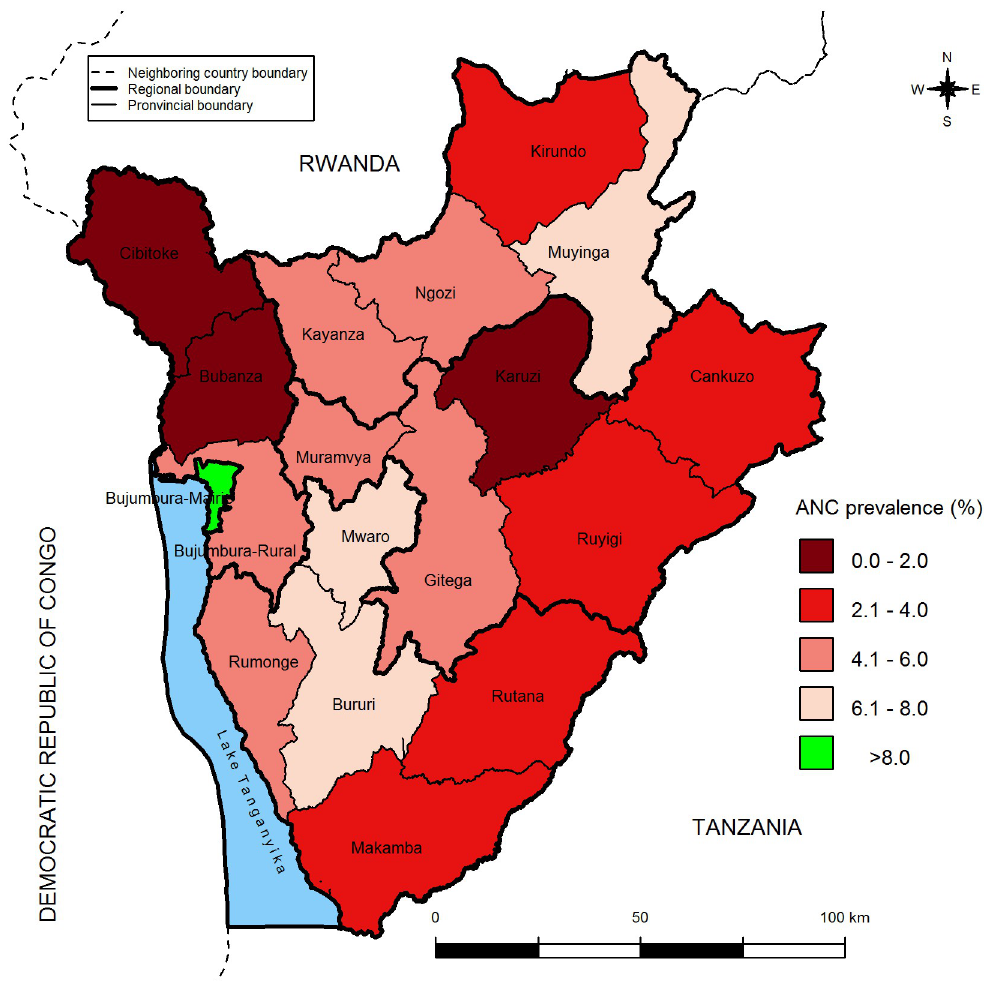
Fig 3. Distribution of provincial ANC prevalence for women aged 15–49